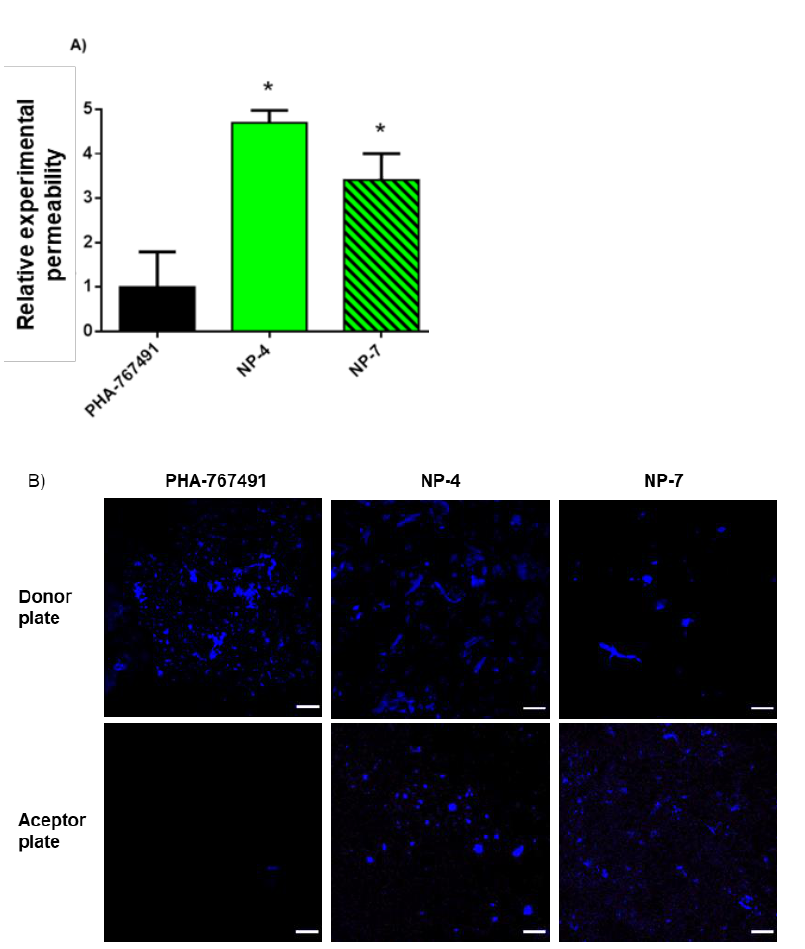
Figure 5. Predicted permeability through the BBB (blood–brain barrier) assayed by PAMPA (parallel artificial membrane permeability assay) methodology. ( A ) Relative experimental permeability of PHA-loaded NPs vs. free PHA. Results are shown as the mean ± SD of two independent experiments. (* p < 0.05 significantly different from free PHA). ( B ) CLSM (confocal laser scanning microscopy) images of donor and acceptor plates after incubation. Scale bars: 20 µm.